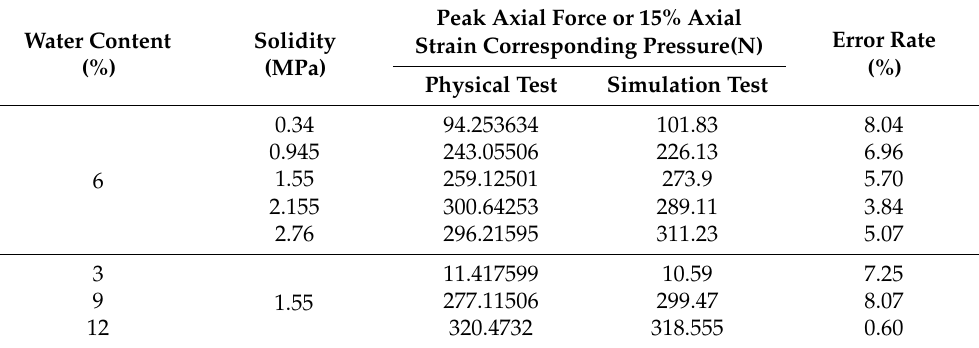
Table 13. Comparison of physical and simulation tests of unconfined compression.